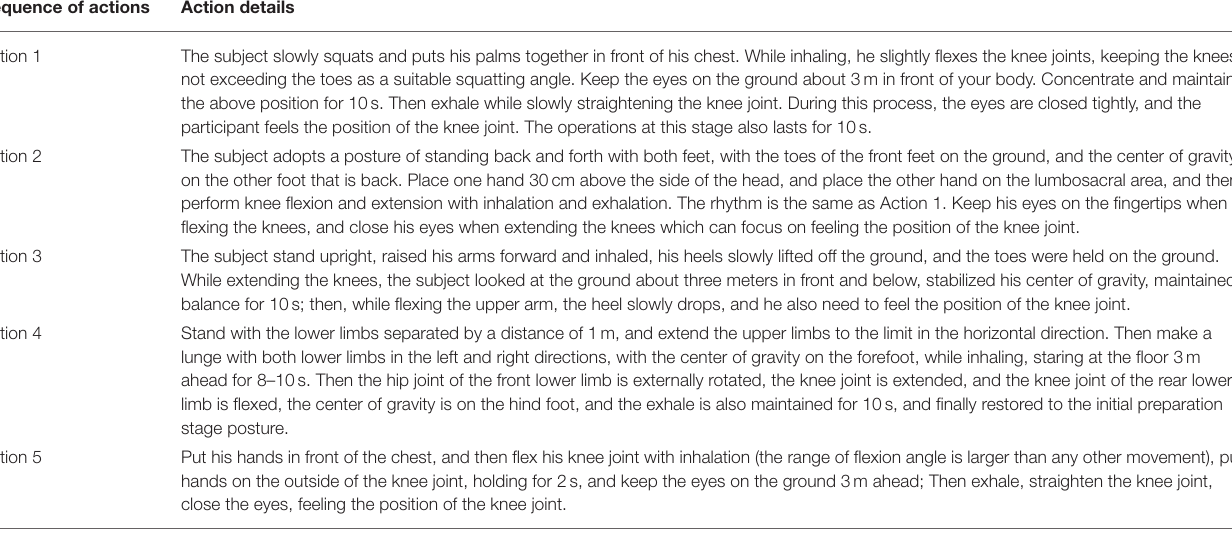
TABLE 1 | Details of the operation of Yijinjing Qigong Exercise (YJJQE). Sequence of